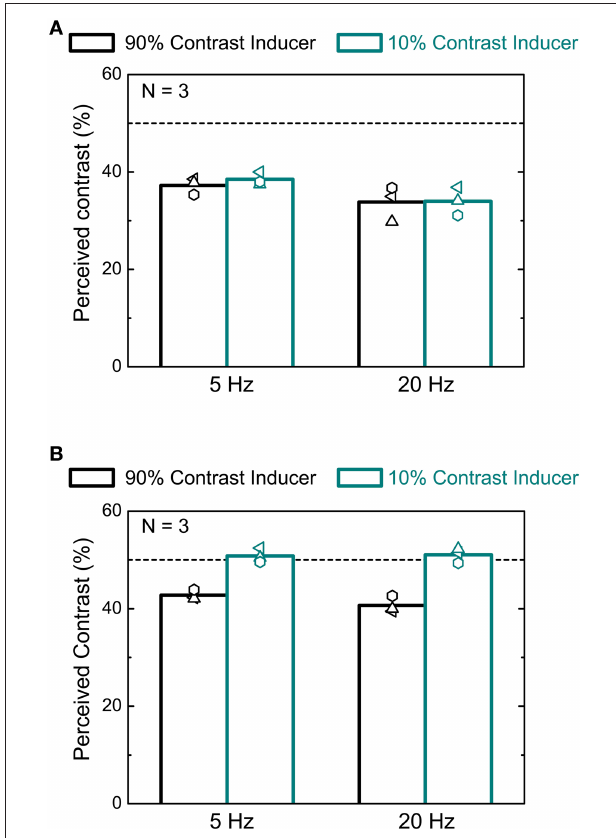
Figure 3 | contrast context induced effects on perceived contrast. (A) Effect of preceding contrast on apparent contrast. In different conditions the standard followed either the 90% (black columns) and 10% (dark cyan columns) intervals. In the graph, for both conditions, we plot the average effects on the perceived contrast of the test interval following 90% contrast as a function of the stimulus frequency. Empty symbols indicate individual data. (B) Estimated contrast (PSE) of a 50% contrast interval after a 90% (black columns) or 10% (dark cyan columns) contrast inducer relative to a simultaneously displayed variable contrast interval displayed in an unadapted position. Data for three subjects and for two temporal frequencies are reported.